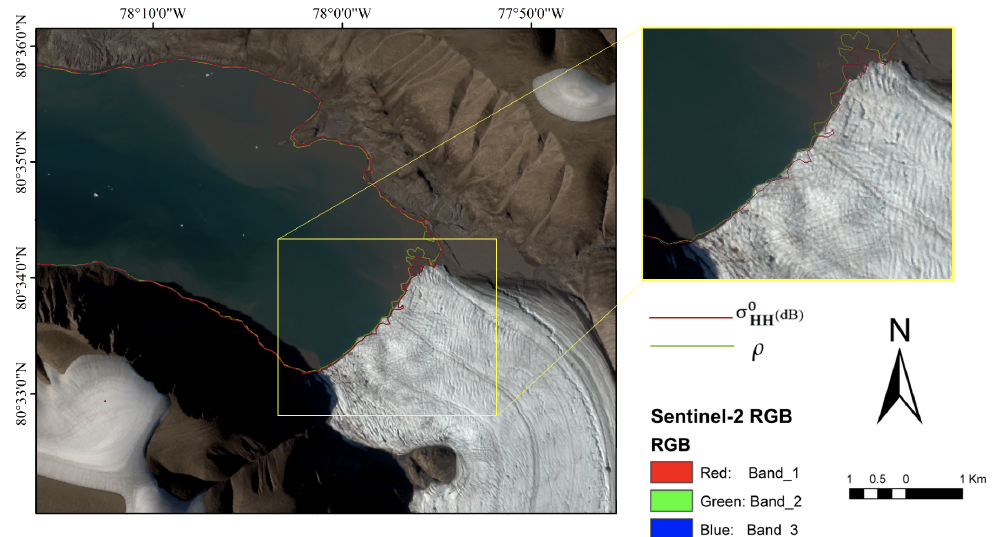
Figure 7. Accuracy assessment of the ice front extraction in the unfrozen case. Ice fronts extracted from σ 0 (red) and ρ (green) are overlaid on the reference optical (Red-Green-Blue, RGB) image HH collected by the Sentinel-2 MSI on 26 July 2020. An enlarged version, highlighted by the yellow box, is shown to better appreciate the results.